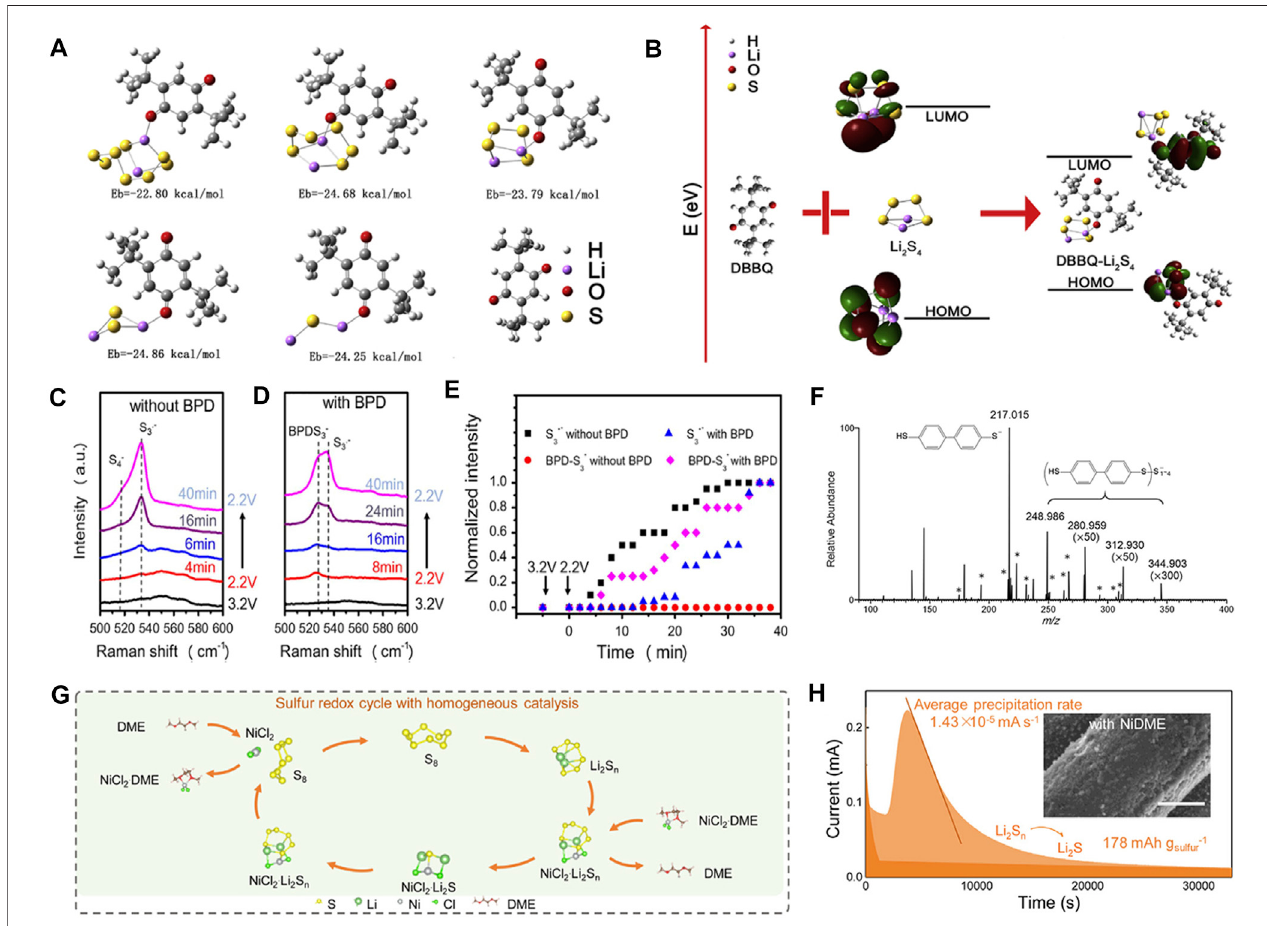
FIGURE 6 | Redox mediators by organic electrocatalysts in electrolyte for the reduction process of Li − S batteries. (A) The stable con fi gurations of DBBQ and DBBQ-Li 2 S x (x (cid:2) 1, 2, 4, 6, 8) with various binding energies. (B) The LUMO and HOMO energy levels of electrolyte before and after the reactions between DBBQ and Li 2 S 4 . (A,B) FigurereproducedfromthedatainWangZ.etal.(2020). (C,D) In-situ RamanspectraofS/Ccathodeswith/withoutBPDadditives. (E) Thepeakintensityof (cid:129) S 3 andBPD-S 3 − asafunctionoftimeunderthepresence/absenceofBPDadditives. (F) ( − )ESImassspectrumofthesame5 mM “ Li 2 S 4 ” solutionwith5 mMBPD. (C – F) Figure reproduced from the data in Wu et al., 2017. (G) Schematic illustration of NiDME additives to catalyze LiPSs in Li − S batteries. (H) Potentiostatic discharge curve of Li 2 S deposition under the addition of NiDME. (G, H) Figure reproduced from the data in Luo et al. (2020).